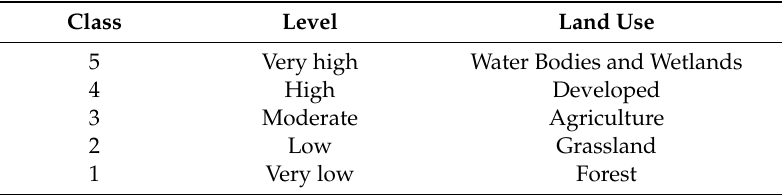
Table 3. Classes for Economic Vulnerability.